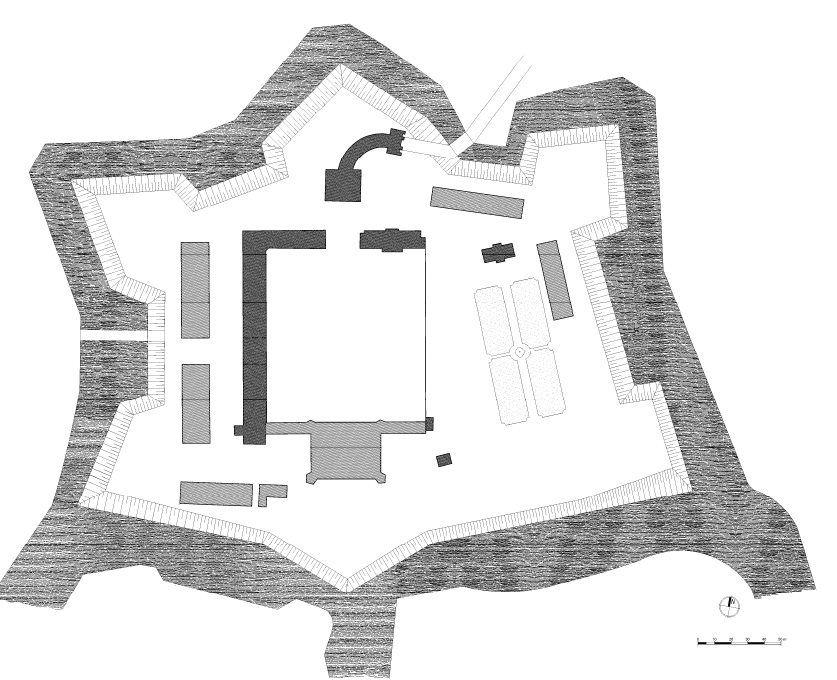
Arts 2021 , 10 , x FOR PEER REVIEW Figure 18. Biała Podlaska: Radziwiłł’s residence—palace plan with fortifications; created by authors. Figure 18. Bia ł a Podlaska: Radziwi łł ’s residence—palace plan with fortifications; created by authors.